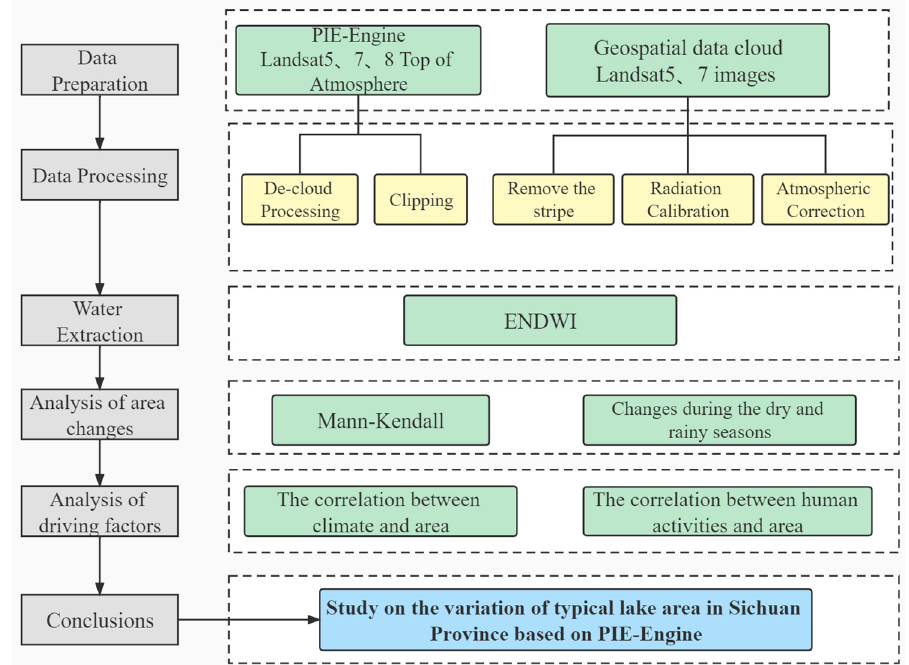
Figure 3. Schematic diagram of the study.